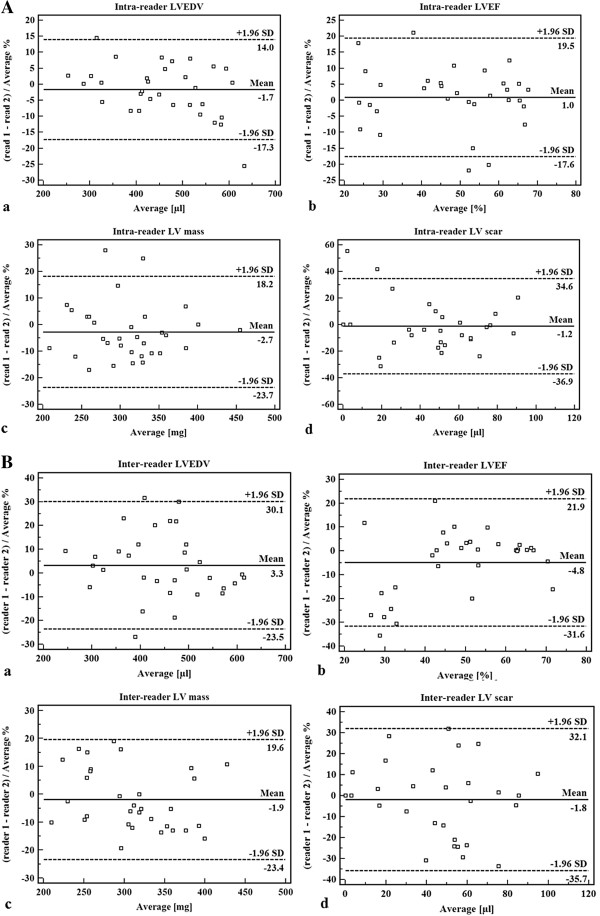
Bland-Altman plots. Intra-reader (A) and inter-reader (B) agreement for the assessment of (a) left ventricular end-diastolic volume, (b) left ventricular ejection fraction, (c) left ventricular mass, and (d) left ventricular scar volume, respectively.